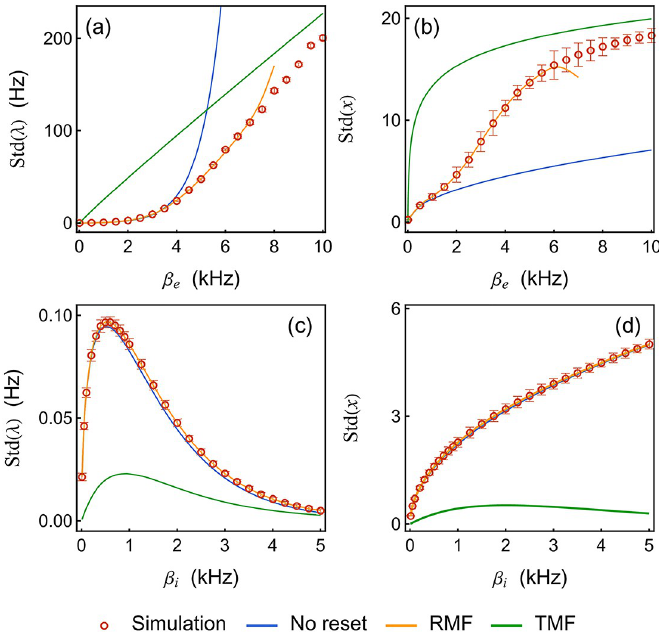
Fig 7. Rate-transfer functions: Standard deviation of the neuron firing rates Std( λ ) and of the internal variables Std( x ). For panel (a) and (b), the neuron is subjected to an excitatory input with varying rates β fixed strength μ e = 1.0. For panel (c) and (d), the neuron is subjected to an inhibitory input with varying rates β i from 0 to 5 kHz and fixed strength μ = − 1.0. For the simulated data, we run the event-driven simulation until 400 spiking i events for the single neuron are accumulated. This process is repeated 32 times. During each repetition, we record the entire time series of the internal variable x , with which we can compute the moment of x for any given order. Std( λ ) is computed from Eq (23) with cut-off order 15. Std( x ) is computed by taking the square root of M standard deviations of the quantities (indicated by error bars) are computed over these 32 repetitions. Parameters: h = 1 Hz, a = 0.1, τ = 10